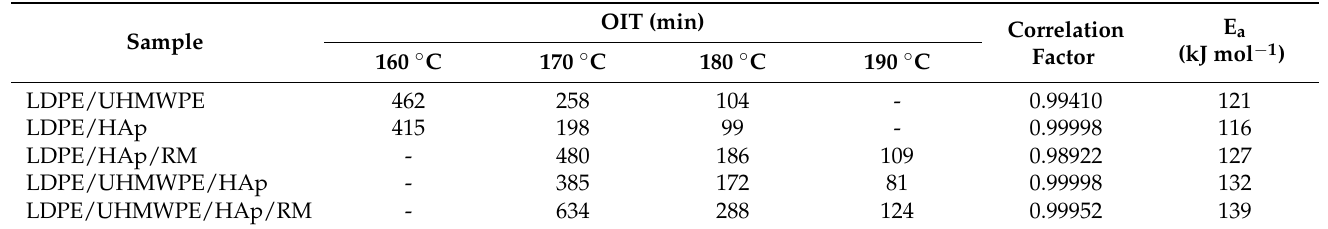
Table 1. Activation energies required for the radiation oxidation of LDPE/UHMWPE compositions irradiated at 50